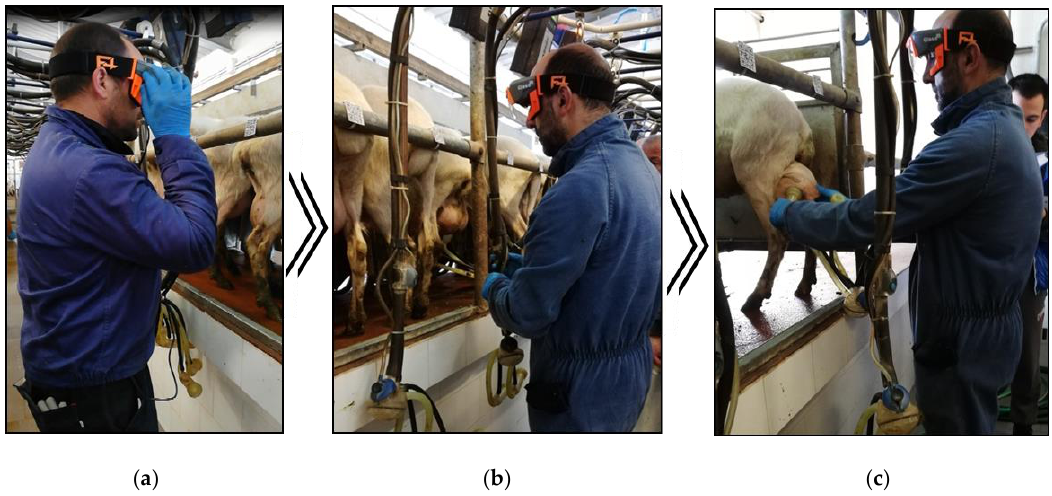
Figure 3. Operation flow carried out in the milking parlor: QR code scanning function activation ( a ); QR code reading ( b ); information visualization and animal identification/selection while milking cluster attachment ( c ).